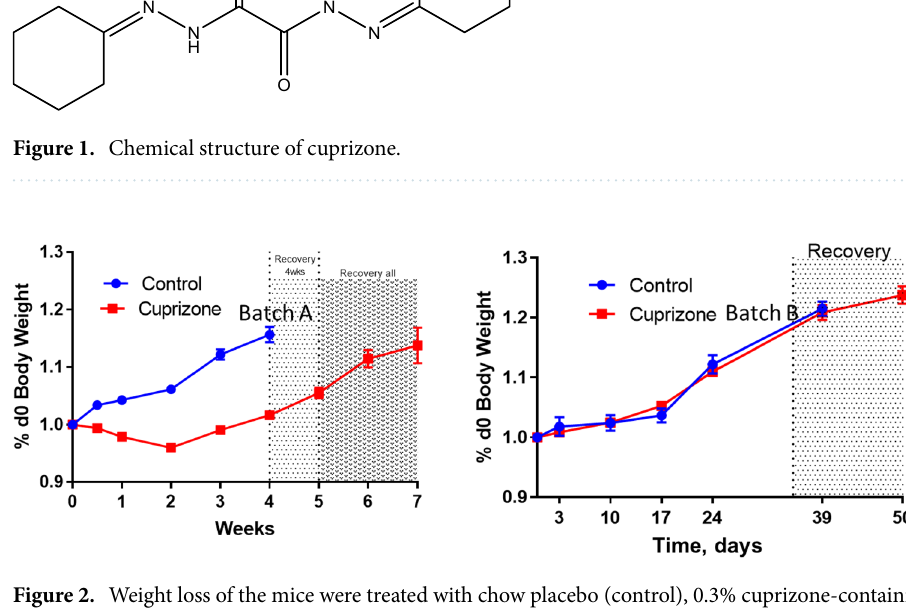
Figure 2. Weight loss of the mice were treated with chow placebo (control), 0.3% cuprizone-containing chow (batch A) and 0.3% cuprizone-containing chow (batch B).